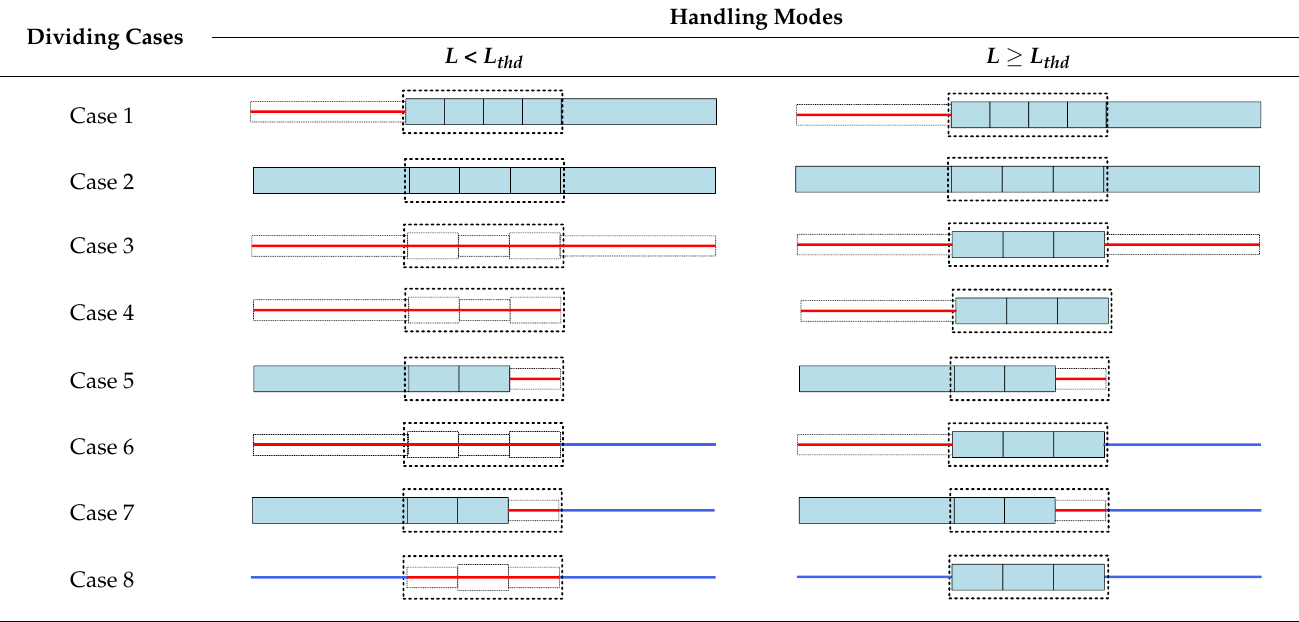
Table 2. Cases of collapse priority strategy.